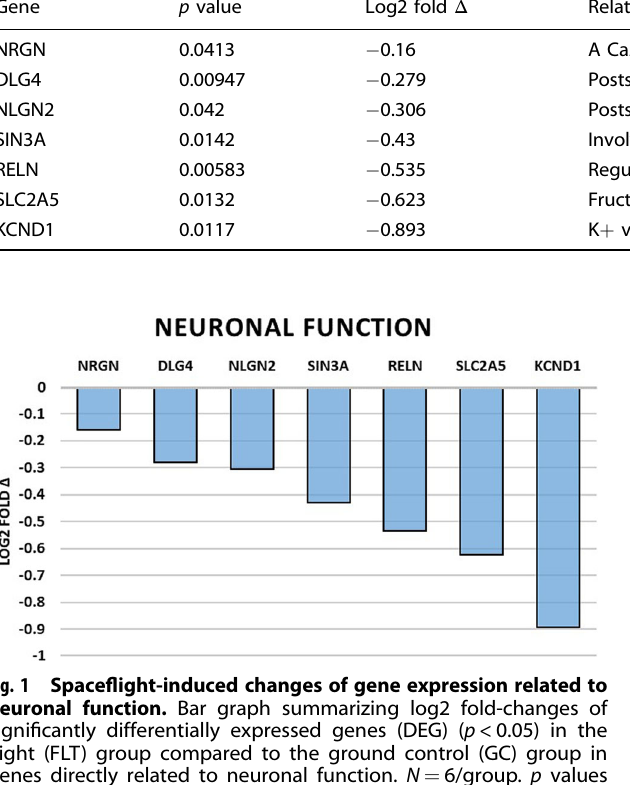
Table 2. Summary of signi fi cantly altered gene expressions by space fl ight related to neuronal function.